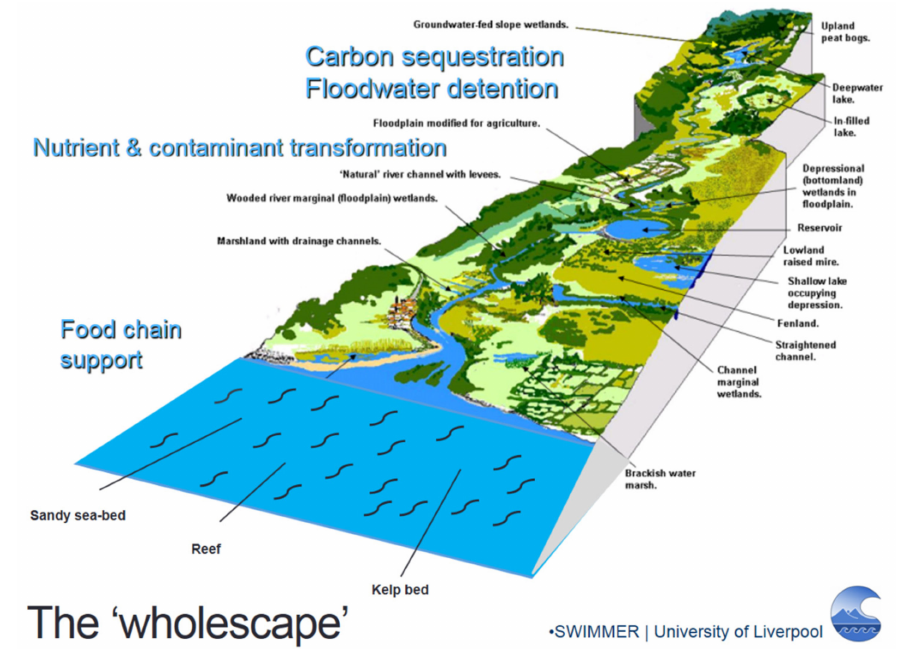
Figure 21. Schematic representation of the Wholescape concept